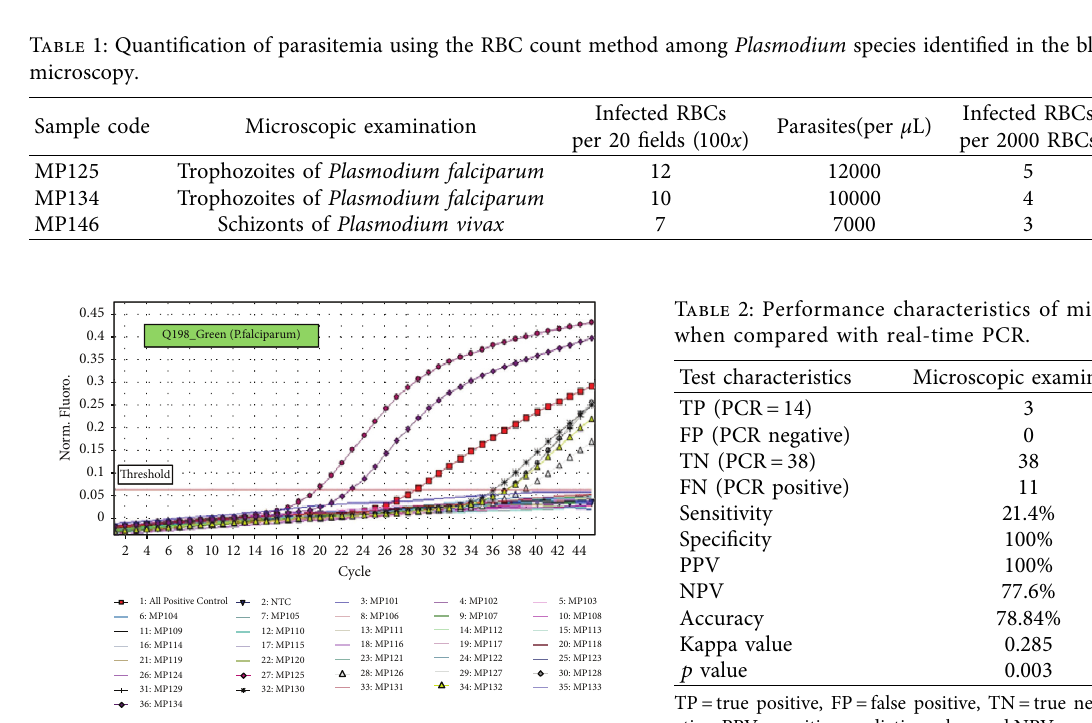
Figure 4: qPCR amplification of blood samples infected by Plasmodium falciparum .